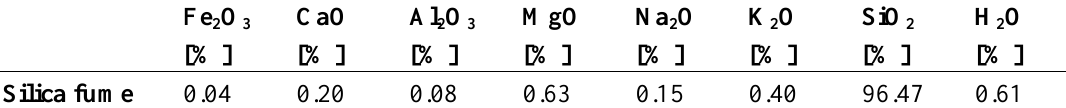
Table 2. Silica fume chemical composition, as obtained by the manufacturer.